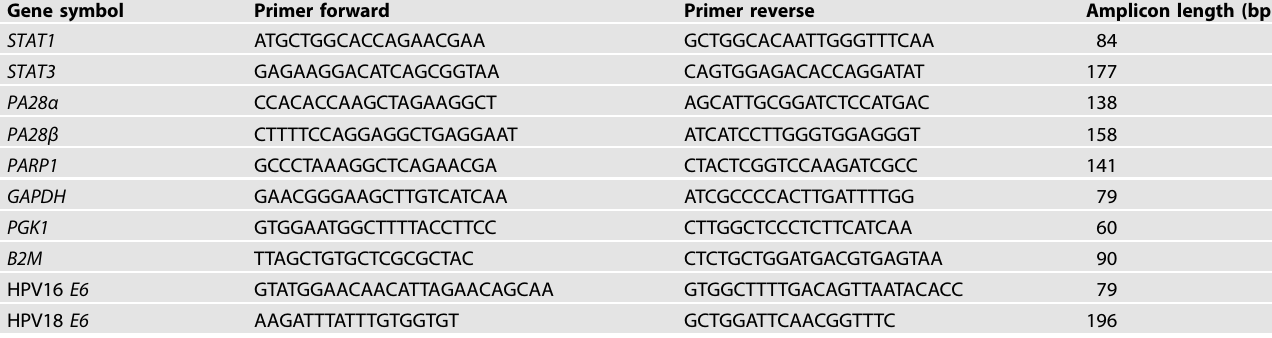
Table 2. Primer sequences used for